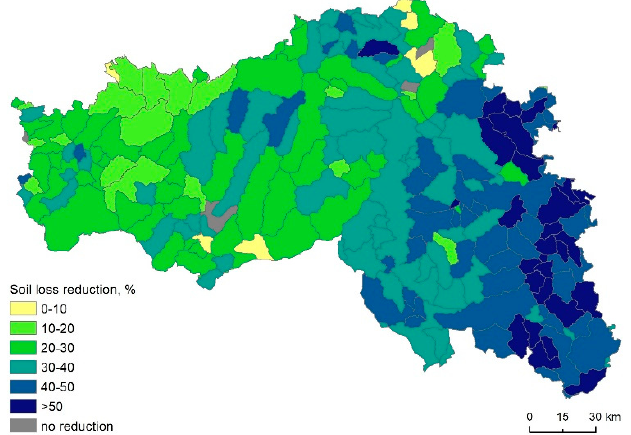
Figure 7. Reduction of modeled erosion-induced soil losses in the studied river basins of Belgorod Oblast after the implementation of ALAS projects.